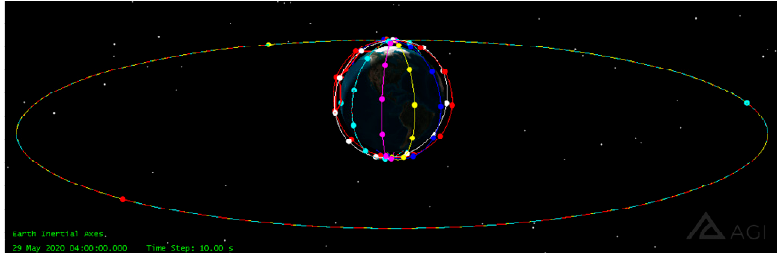
Figure 5. The 3D view of satellite constellations.